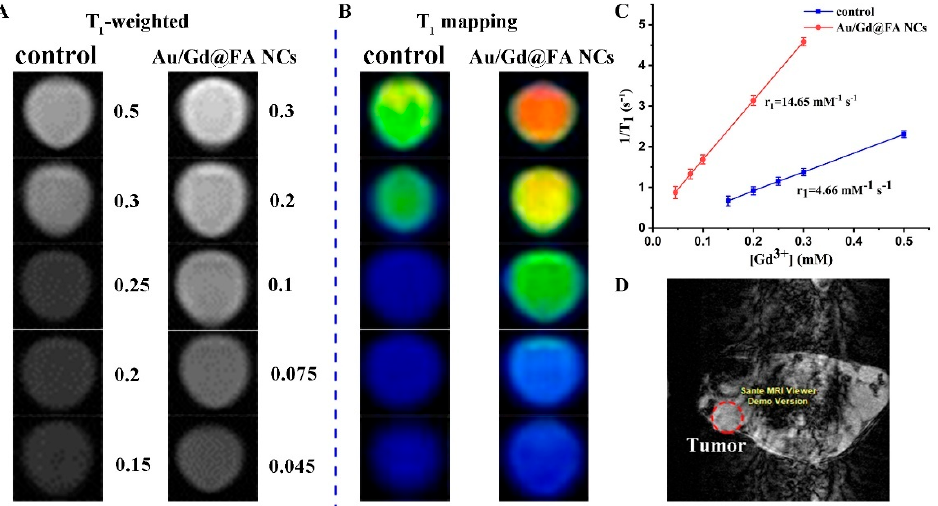
Figure 6. T 1 -weighted MR images ( A ) and T 1 -weighted MRI mapping ( B ) of Au/Gd@FA NCs and Gd-DTPA in an aqueous solution at different Gd concentrations. ( C ) Linear fitting of 1/T 1 versus the Gd concentration. ( D ) T 1 -weighted MRI in vivo (tumor is indicated with a red dotted ellipse). The results of near-infrared FL imaging and T 1 -weighted MRI showed that the pre- pared Au/Gd@FA NCs had good near-infrared fluorescence properties and a strong T 1 effect. In the presence of FA, Au/Gd@FA NCs actively accumulated effectively in the tu- mor and achieved near-infrared FL imaging and T 1 -weighted MRI at the tumor site. Mean- while, combined with metabolic analysis, the residual amount of Au/Gd@FA NCs in vivo is small and has excellent biosafety. Combined with the fluorescence detection results, Au/Gd@FA NCs are expected to be metabolizable dual-mode contrast agents for near- infrared FL imaging and T 1 -weighted MRI. 3.6. Intracellular ROS Detection and Analysis by Laser Irradiation In vivo FL imaging and MRI studies, Au/Gd@FA NCs have been found to be actively enriched at the tumor site. Due to the strong SPR absorption band of gold-based nanopar- ticles, Au/Gd@FA NCs enriched in large amounts at tumor sites are highly susceptible to heat generation under light due to the strong SPR effect, which affects the physiological metabolism of tumor cells. Under laser irradiation at 660 nm (1.2 W/cm 2 ), the temperature of Au/Gd@FA NCs solution (60 μ g/mL) increased from 21 °C to 46.1 °C within 6 min, while PBS as the control group only increased to 35.4° C (Figure 7A). The results indicate that Au/Gd@FA NCs solution can convert light energy into heat energy under laser irra- diation and has some photothermal conversion ability. In addition, we investigated the changes of ROS in tumor cells after co-incubation with Au/Gd@FA NCs under laser irra- diation. The generation of ROS in cells was detected using the sensitive fluorescent dye DCFH-DA, and the fluorescence intensity was proportional to the generation of ROS. Au/Gd@FA NCs (60 μ g/mL) were co-incubated with 4T1 cells for 8 h, and then DCFH-DA solution was added for further incubation for 45 min, and the fluorescence intensity was observed under the confocal fluorescence microscope. As shown in Figure 7B, after 660 nm (1.2 W/cm 2 ) laser irradiation for 6 min, the 4T1 cells showed clear green fluorescence, indicating that a large amount of ROS was produced in the cells. However, there was only a weak fluorescence signal in the non-irradiated group, indicating that the ROS content in the cells was low. The fluorescence intensity in the laser irradiation group was 5.3 times higher than that of the non-irradiated group (Figure 7C). This indicated that Au/Gd@FA NCs could generate a large amount of ROS in tumor cells under light irradiation, which might be due to the enhanced interaction between bipolar FA molecules and plasma field Au/Gd@BSA NCs [41].